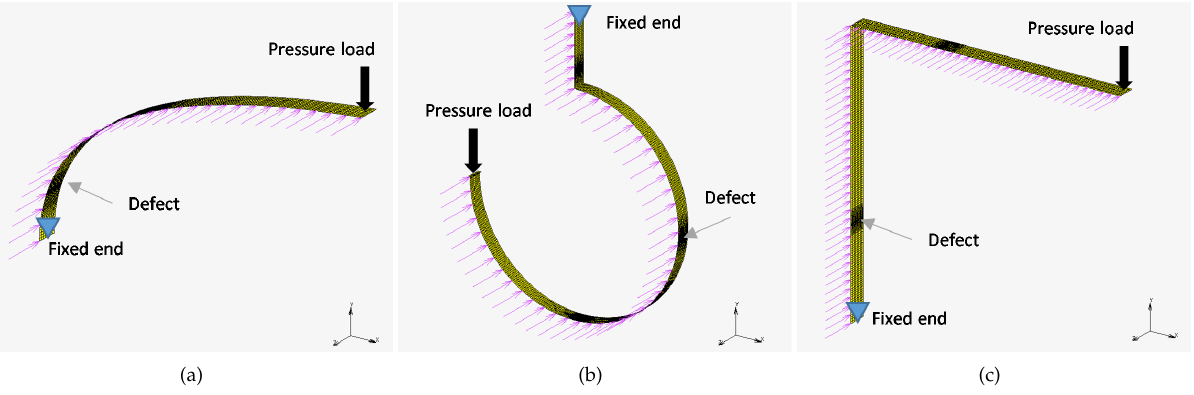
Figure 2. Three structures used for initial AMS verification: ( a ) a curved beam, ( b ) a hook, and ( c ) an L-shaped